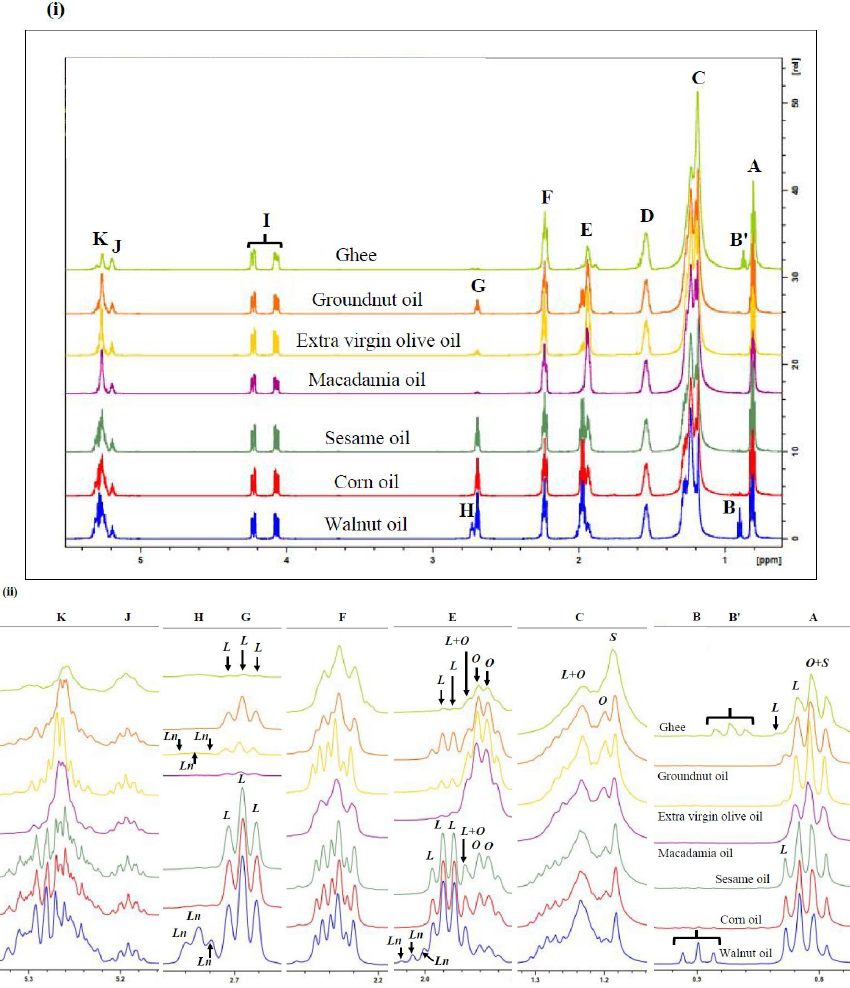
Figure 1. 1 H NMR spectra of ( i ) major acylglycerol function resonances present within the 0.0 – 5.4 ppm regions of unheated culinary oils. Letter assignments of resonances correspond to those provided in Table 2. 1 H NMR spectra of ( ii ) expanded regions of resonances A, B, C, E, F, G, H, J and K present within the 0.0 – 5.4 ppm regions of unheated culinary oils. Abbreviations: S — saturated fatty